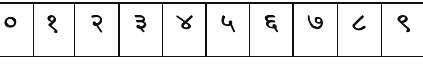
Figure 2: Valid sample database.